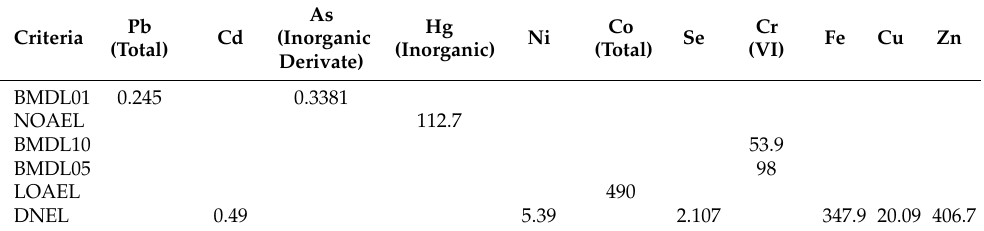
Table 5. Criteria of the toxic elements’ limits [mg/kg bw/week] calculated for person of 70 kg body weight (bw) per